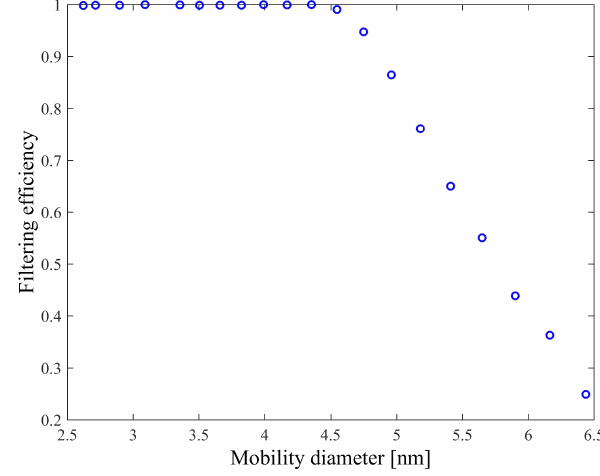
Figure 12. Measured ion filtering efficiency of the new sampling system as function of the mobility